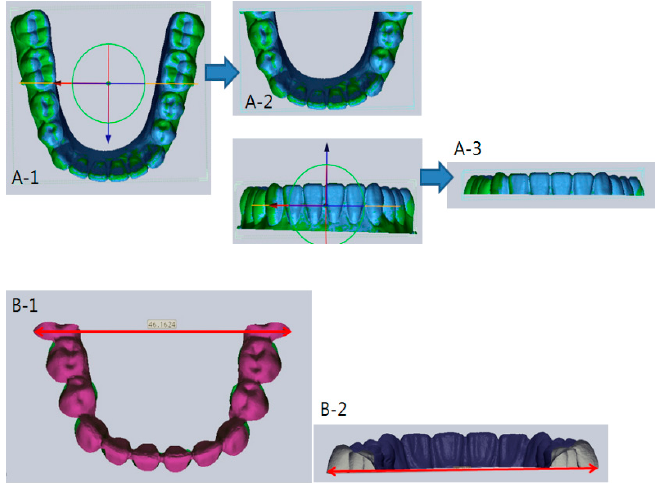
Figure 6. Sequence of measuring intermolar width. A - 1 , Setting a reference plane that passes through the molar resin ball of both sides, and then divide; A - 2 , Setting a reference plane that passes through the most prominent point of the first molars of both sides, and then dividing; A - 3 , Shows the divided model for measuring intermolar width; B - 1 and B - 2 , Shows the intermolar width